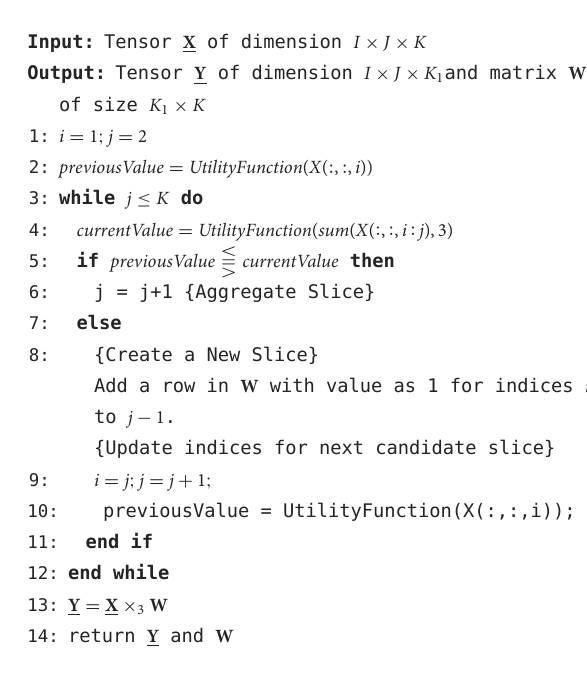
Algorithm 1. I CE B REAKER